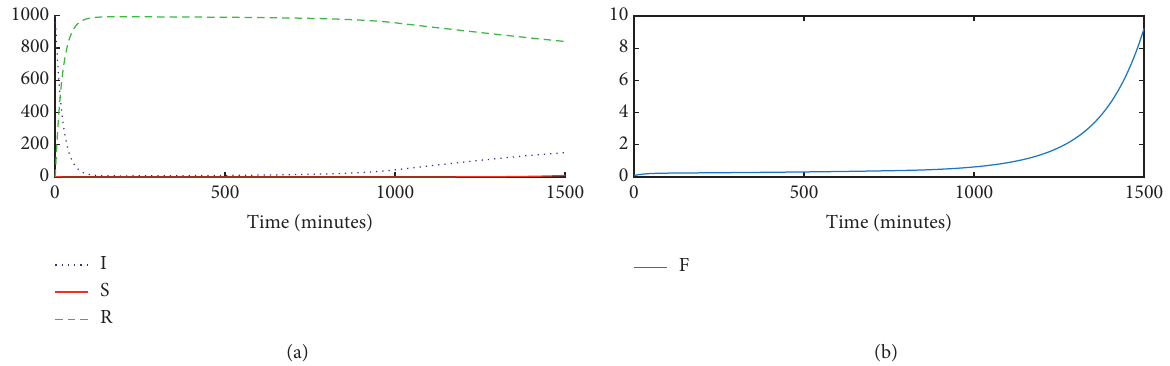
Figure 3: Dynamic of systems (5)–(8) with controls. (a) Behavior of the Ignorant (I), Sharers (S), and Removed (R). (b) The amount of information (F).